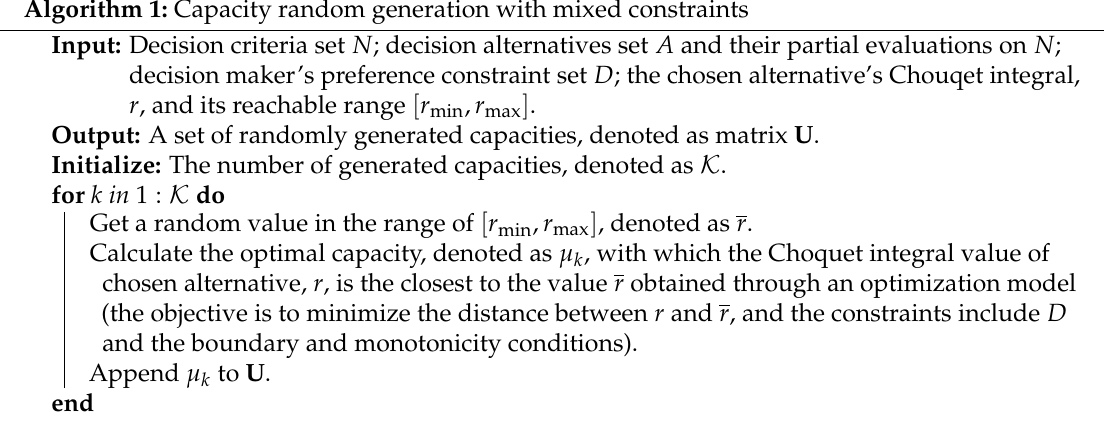
Algorithm 1: Capacity random generation with mixed